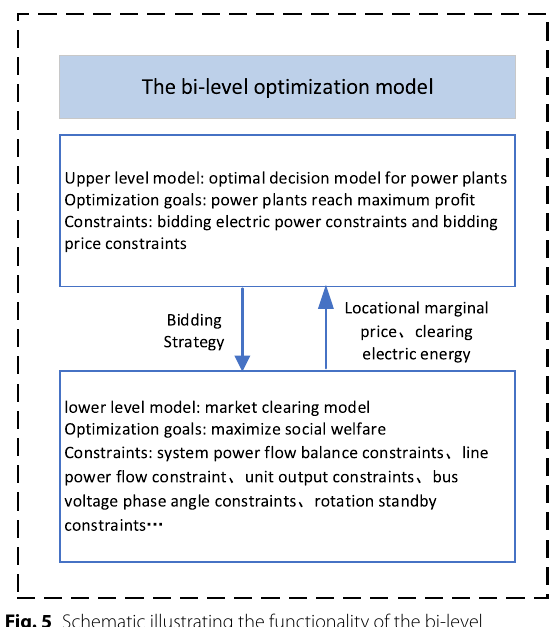
Fig. 5 Schematic illustrating the functionality of the bi-level optimization